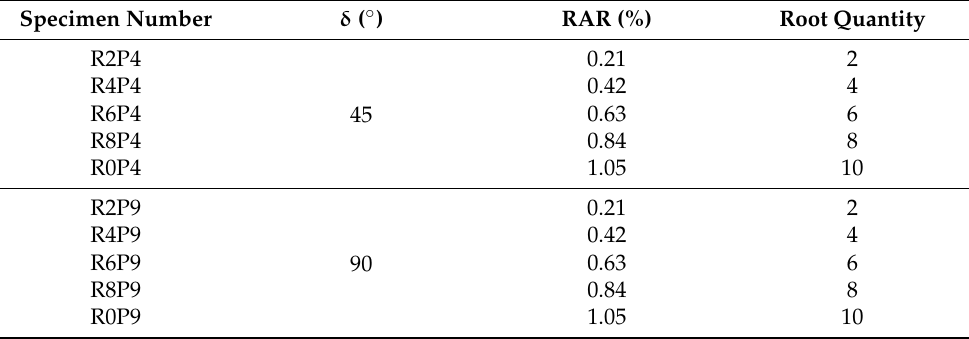
Table 3. Sample number and material parameters of direct shear test with root-bearing soil.